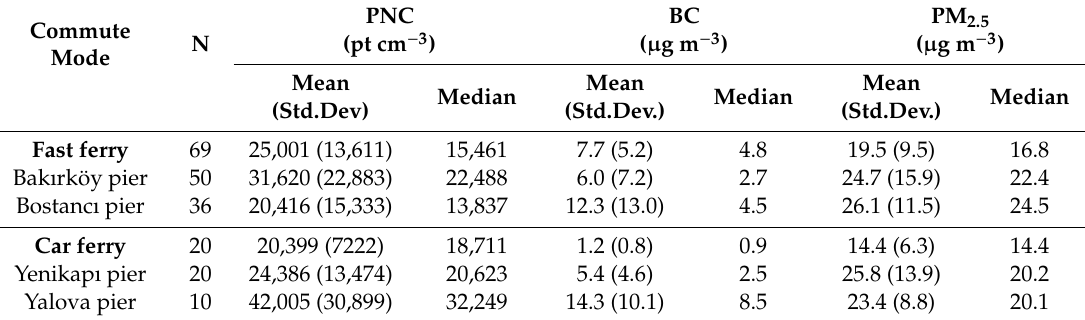
Table 2. Pollutants descriptive in ferry and at the